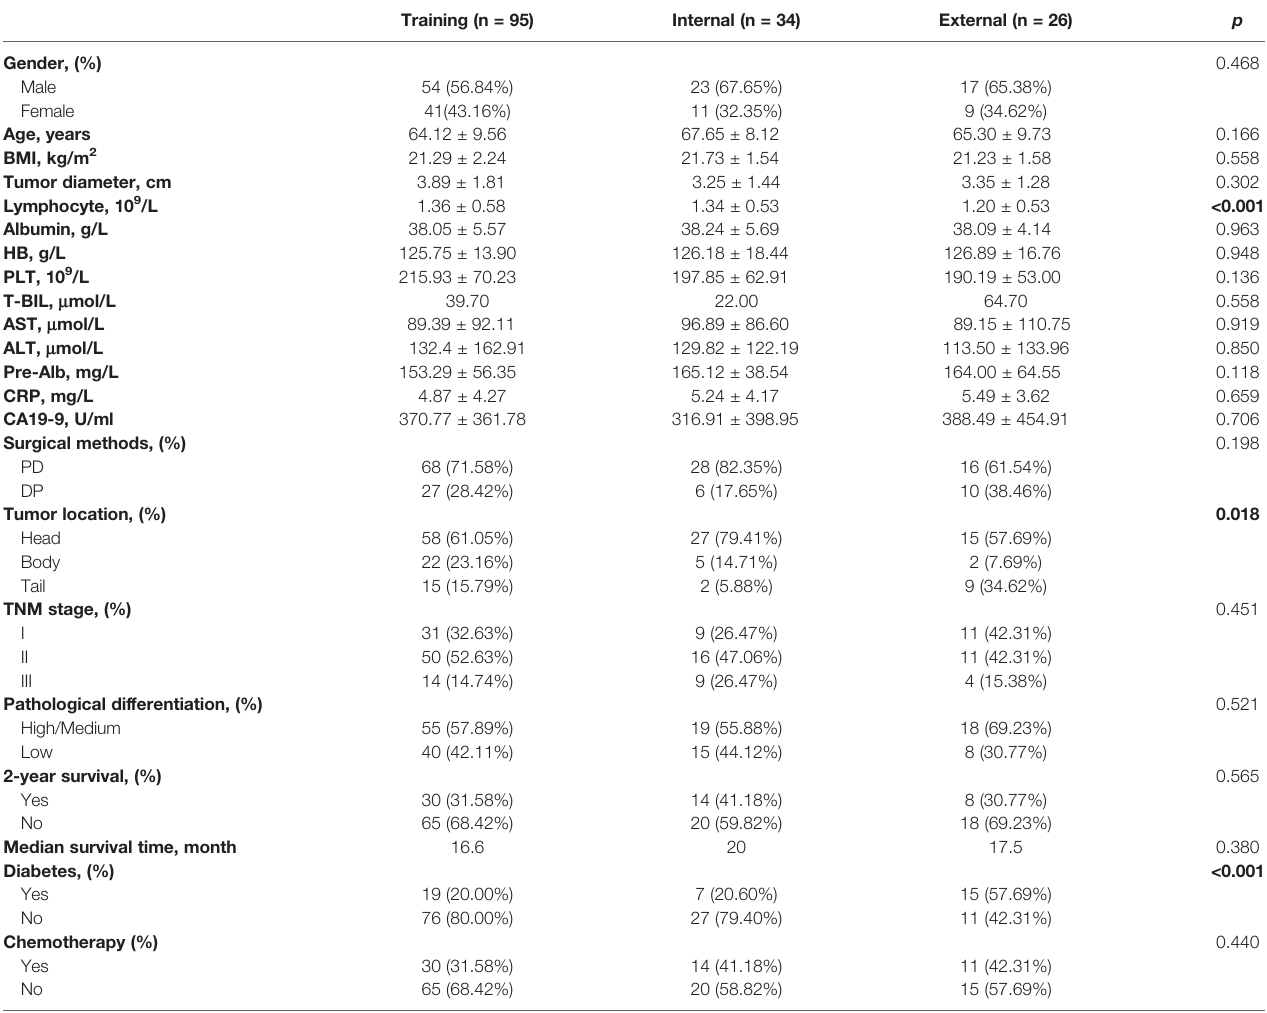
TABLE 1 | Demographic and clinical characteristics of patients in the training and validation